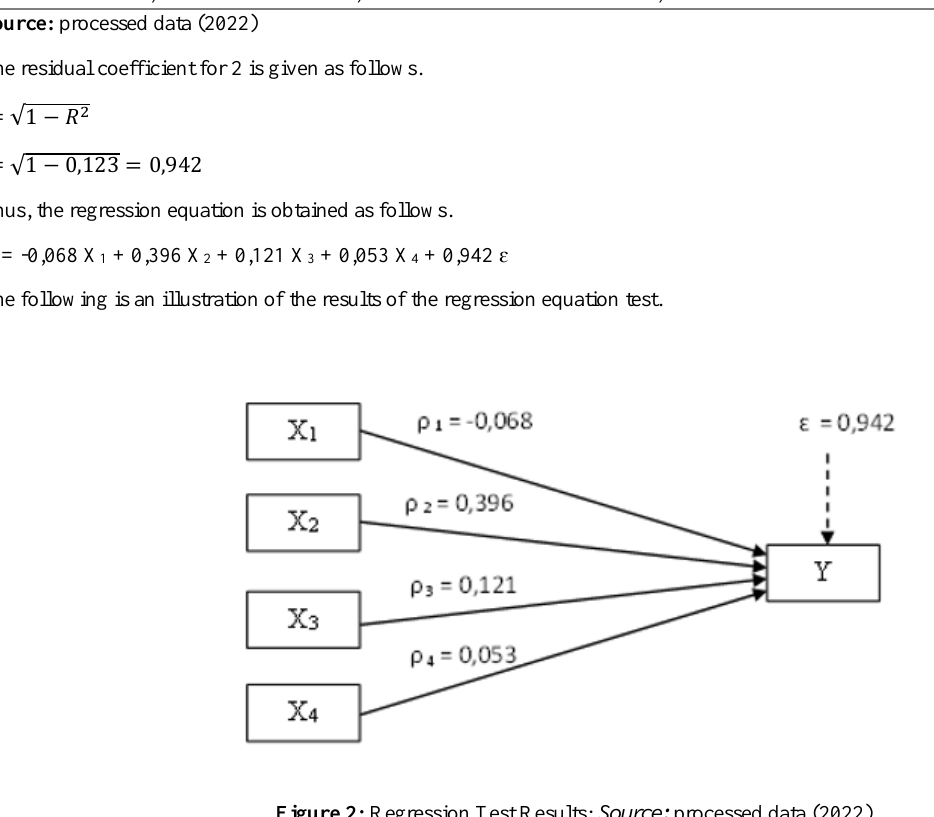
Figure 2: Regression Test Results; Source: processed data